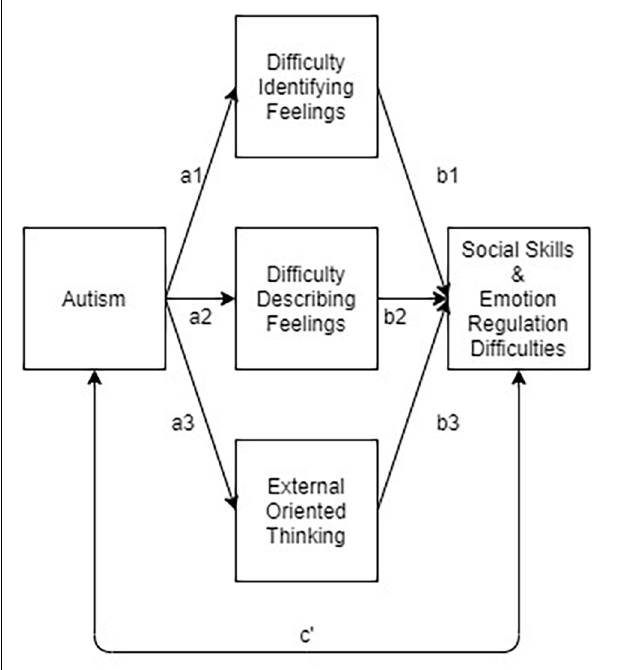
FIGURE 1 | Proposed mediation model of the relationship between ASD traits (AQ), alexithymic traits (TAS-20) and social skills (ICQ), and emotion regulation abilities (DERS). Separate analyses were conducted for the ICQ and DERS,